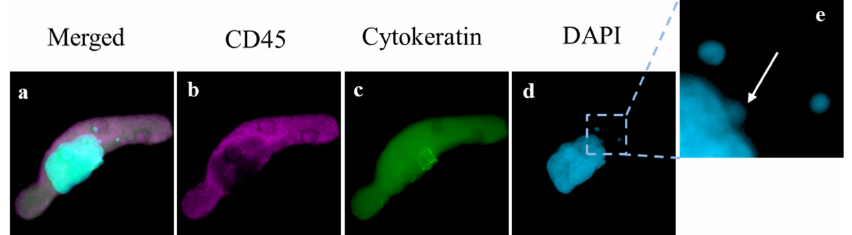
Figure 1. Image of CAML with Micronuclei. ( a – d ) single CAML with enlarged nucleus (blue) diffuse Cytokeratin (green) and CD45 (violet) indicating cell structure (Box = 85 µm). ( e ) Enlarged portion of cell with one micronuclei budding from the primary nucleic mass (white arrow) and two separate distinct micronuclei also within the cell cytoplasm (Box = 20 µm).